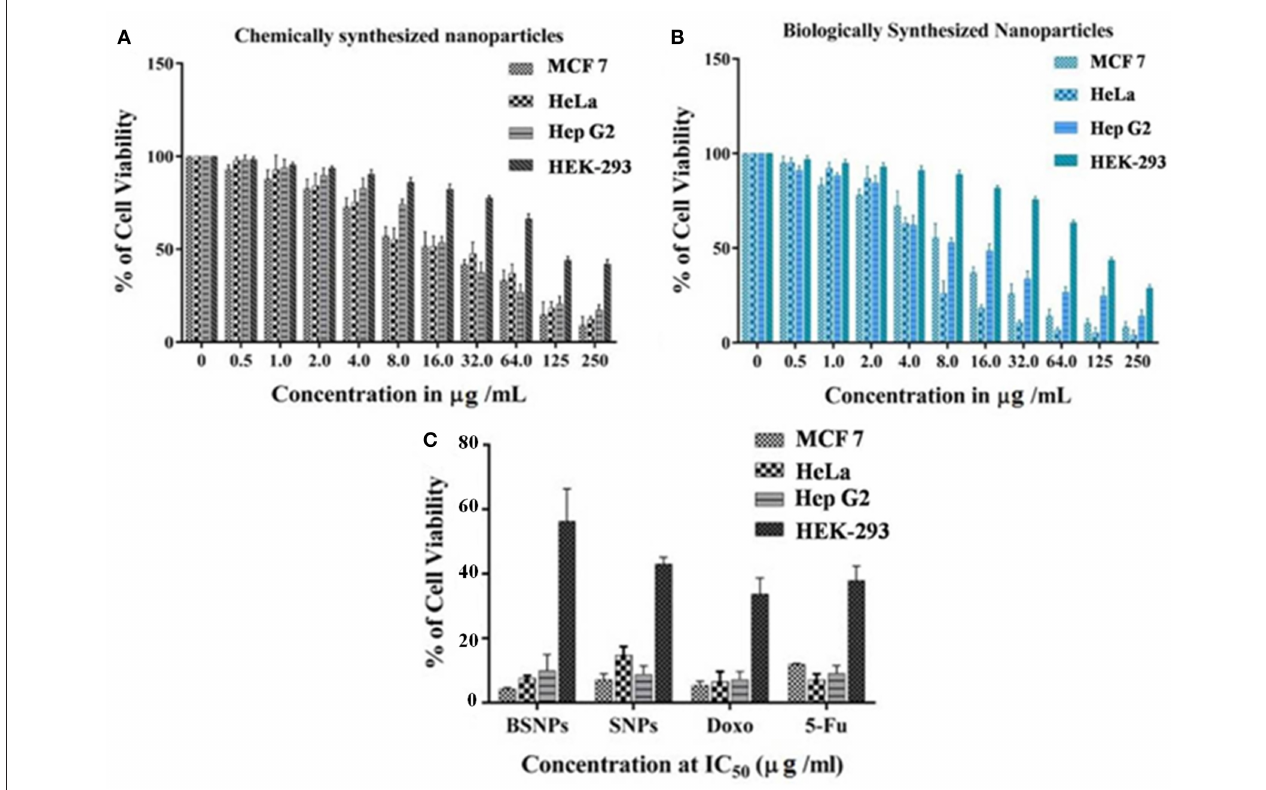
FIGURE 5 | Experimental observation of the cytotoxic property of P.indica -derived Ag NPs, (A,B) cytotoxic activity of chemically Ag NPs and biogenic synthesized Ag NPs at different concentration against cancer cell lines. Experiments were performed in triplicates; the error bar represents statistically significant differences ( p < 0.05). (C) Cytotoxic activity (IC 50 ) of biogenic silver nanoparticles (BAgNPs) and chemically silver nanoparticles (SNPs) against human carcinoma cell lines and normal cells (HEK-293). Doxorubicin (Dox) and 5-Fluorouracil (5-Fu) are used as reference drugs.